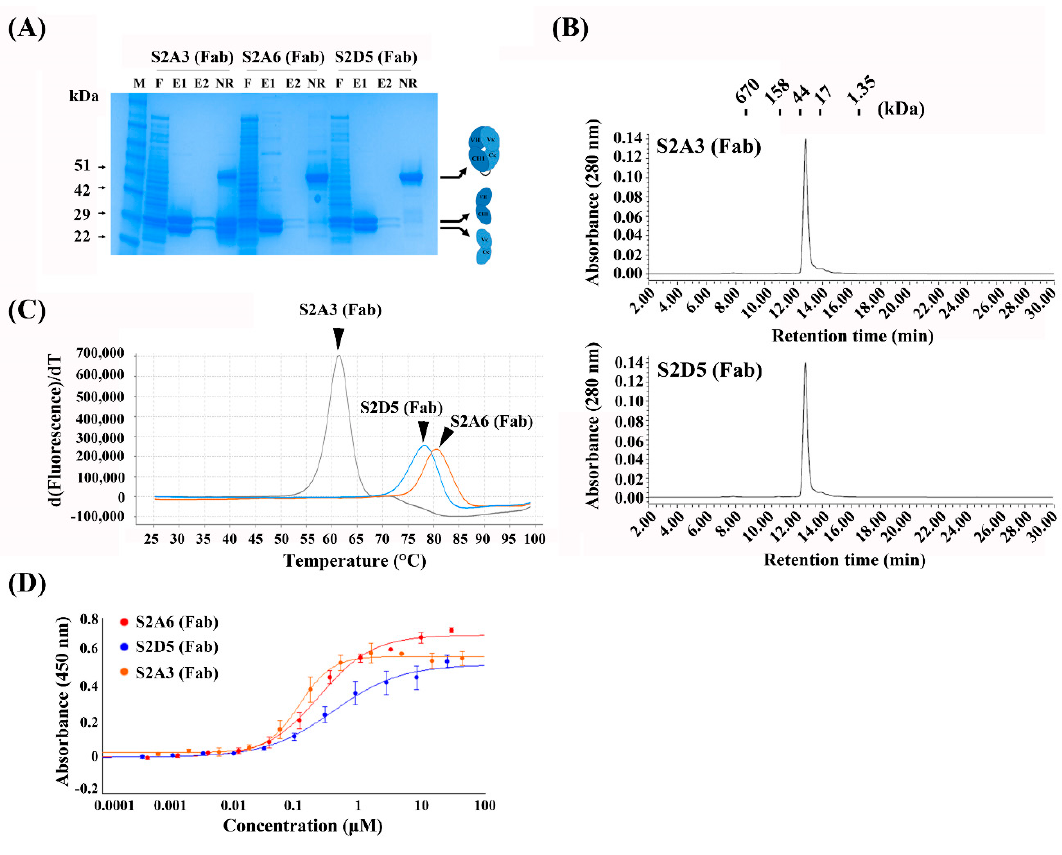
Figure 2. Production and characterization of anti-MERS-S2P Fabs. ( A ) SDS-PAGE analysis of anti-MERS-S2P Fabs purified from periplasmic extracts of E. coli transformed with the